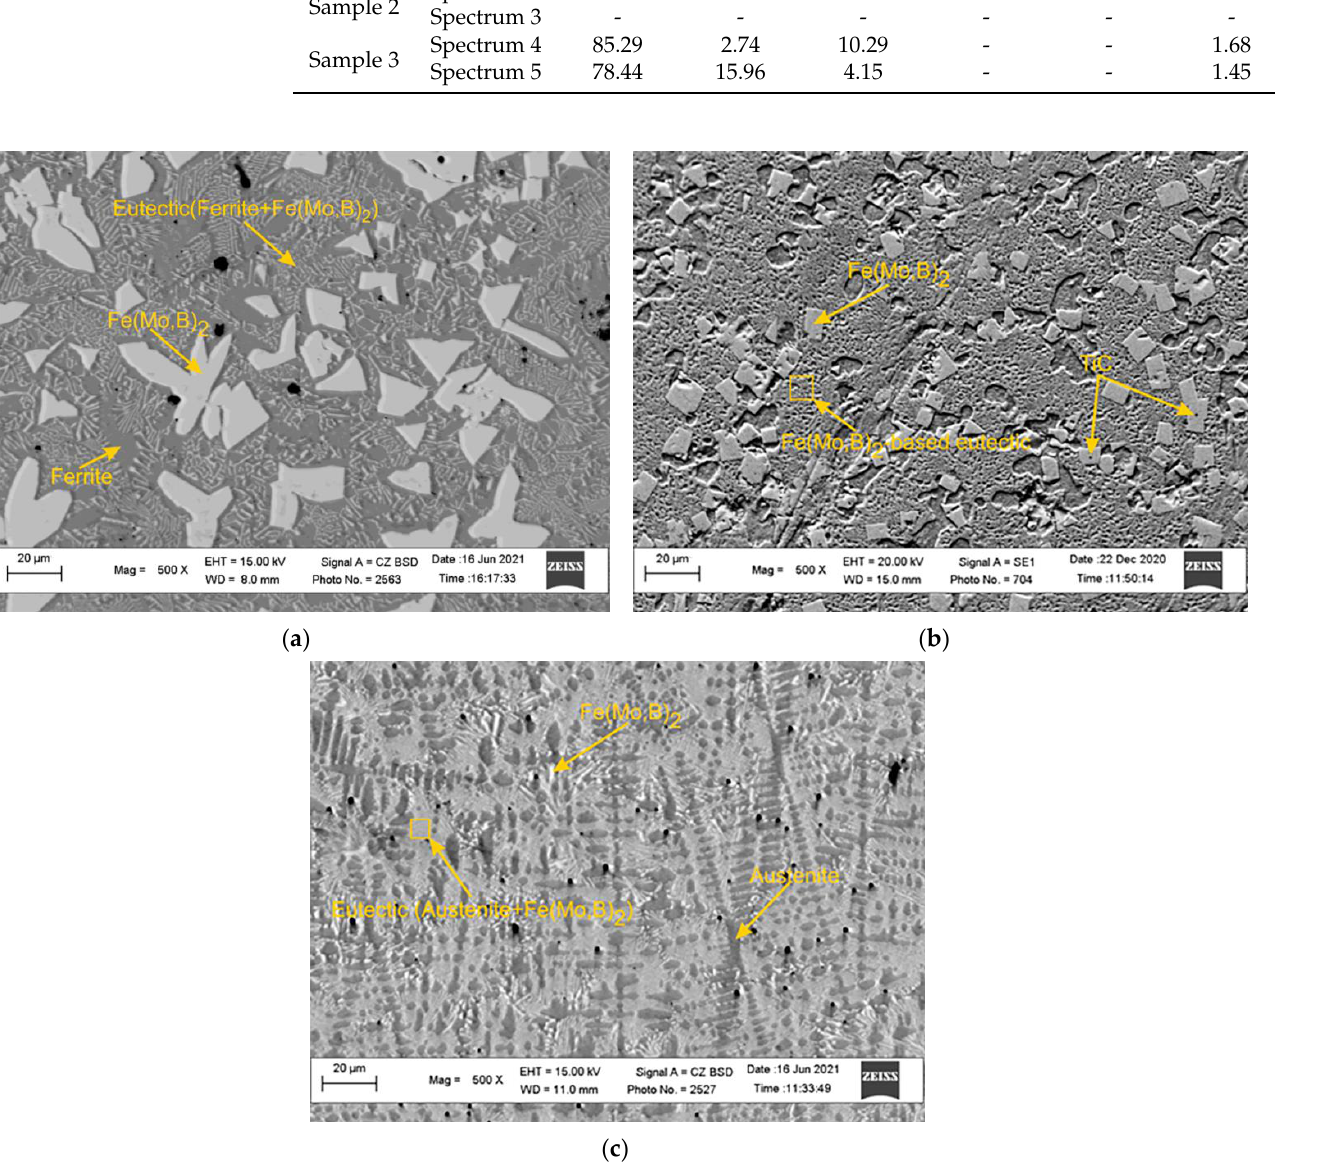
Figure 9. The microstructure of the experimental hardfacing alloys: ( a ) Sample 1; ( b ) Sample 2; ( c ) Sample 3.